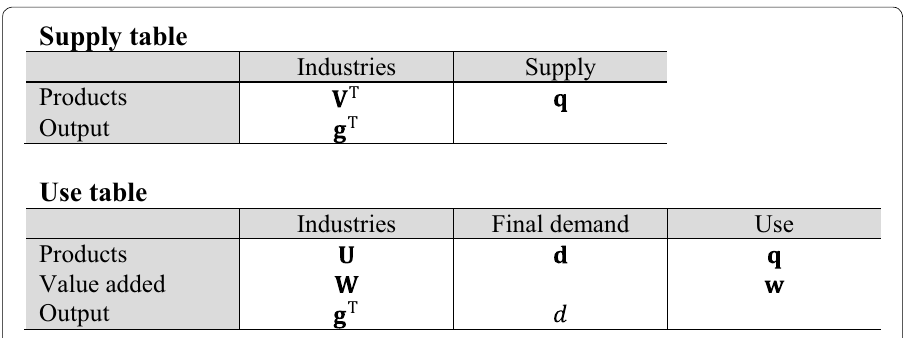
Fig. 2 Format of the SUT with the definition of the symbols. Based on Eurostat (2008, p.